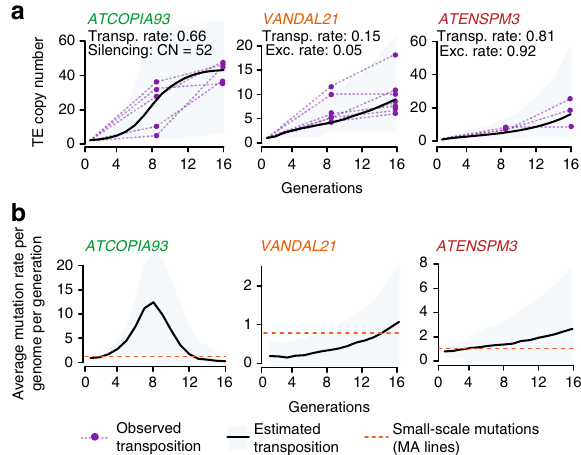
Fig. 2 Transposition follows a chain reaction in the epiRILs. a Dynamics of insertion accumulation for the three TE families. Observed data obtained at F8 and F9 for ten epiRILs is shown for epiRILs harboring new private insertions. b Average rate across generations of TE-induced (black line) and small size mutations (red line) obtained using the epiRILs and MA lines 10 , respectively (bottom panels). Gray area represents 95% C.I. Transposition and excision rates per copy per generation, as well as TE copy number (CN) required for triggering concerted epigenetic silencing are